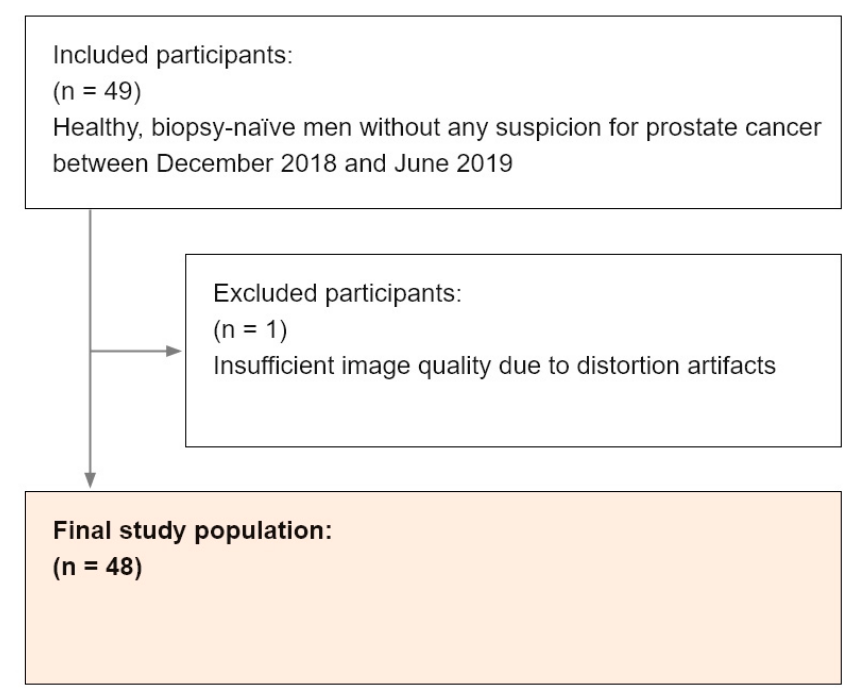
Figure 4. Flowchart outlining the selection of the final study population with utilized inclusion and exclusion criteria within the defined observation window.